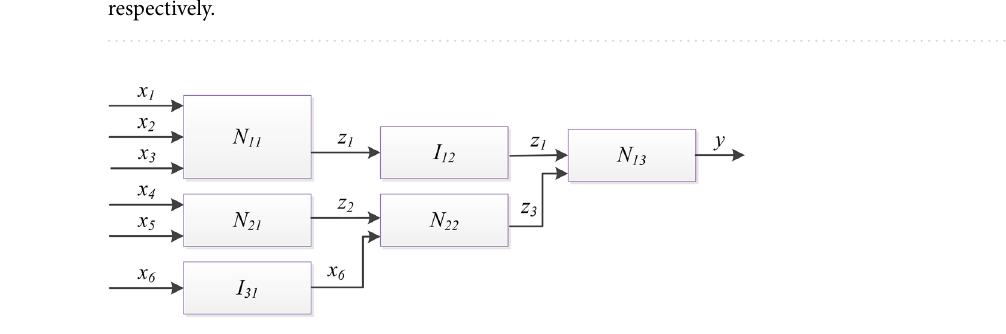
Figure 10. Simple FCM-FN model with 3 numerical inputs and 3 sematic